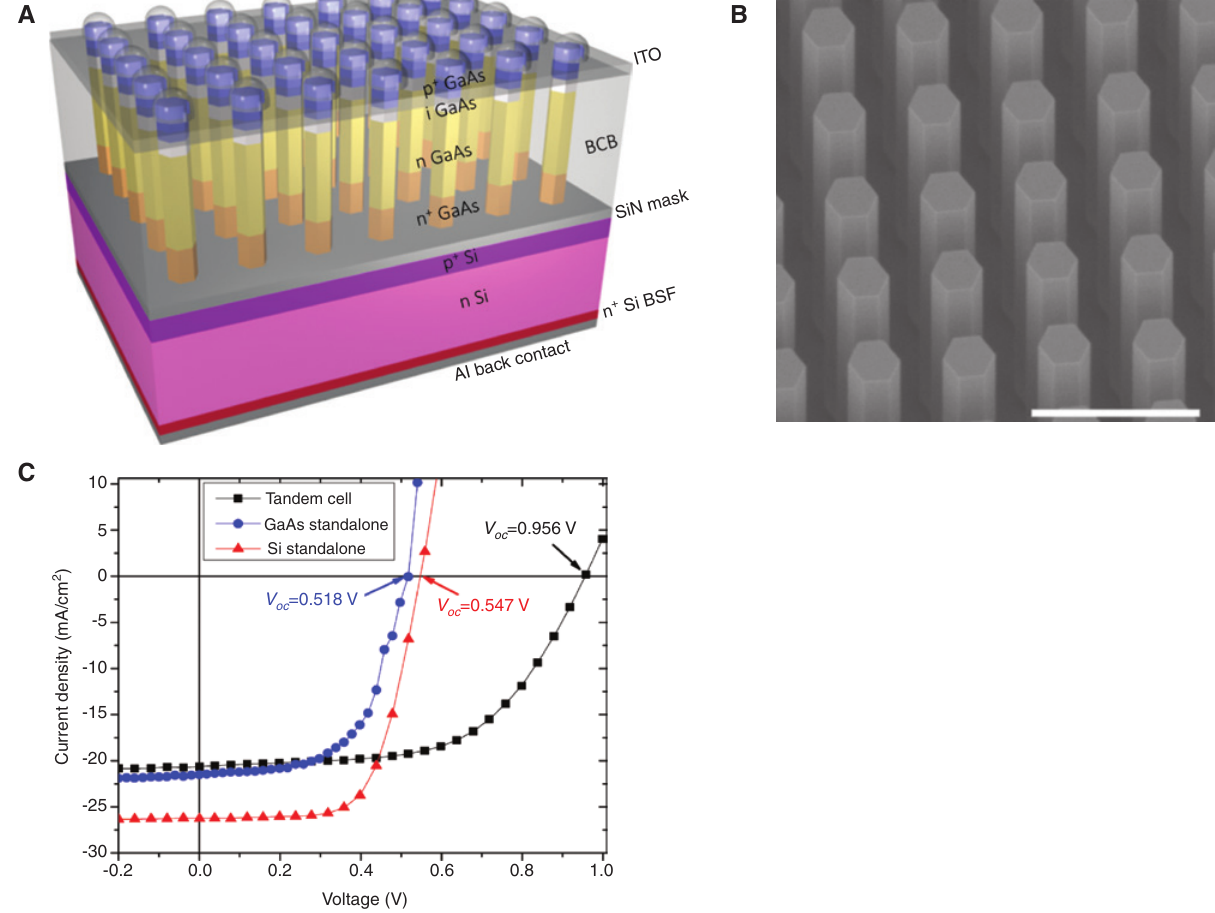
Figure 1: (A) Schematic diagram of the GaAs nanowire on silicon tandem cell. (B) SEM image of the grown GaAs nanowires showing high growth yield. The scale bar is 1 μ m. (C) Measured current-voltage characteristic of the GaAs nanowire junction (blue circles), silicon junction (red triangle), and tandem cell (black square). The measured open-circuit voltage is approximately the summation of the open circuit current of both junctions